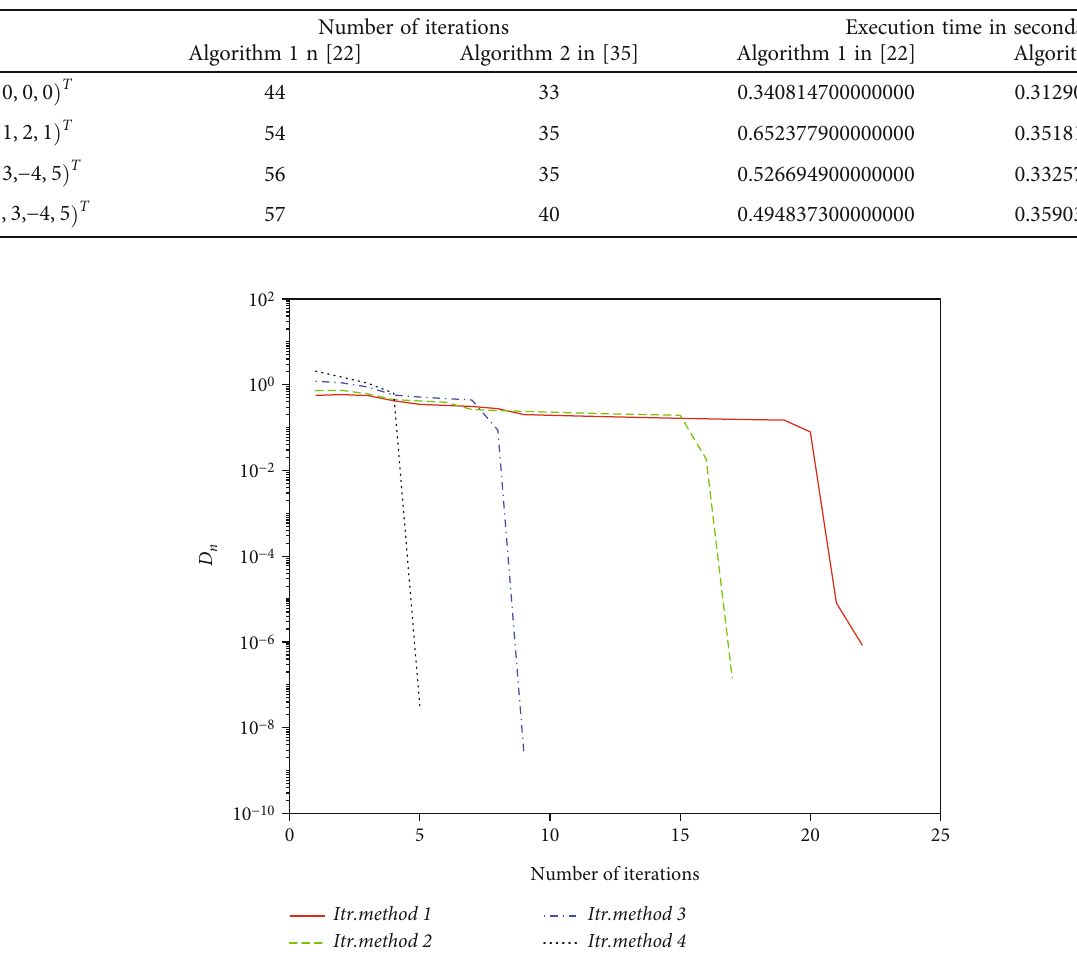
Figure 9: All methods are compared computationally while x